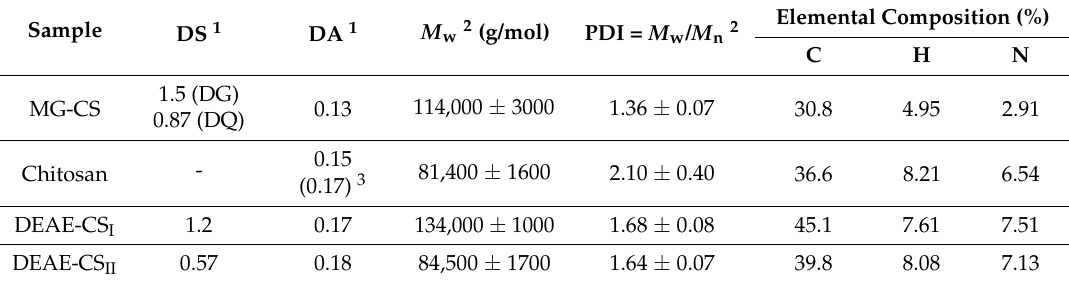
Table 1. Characteristics of the chitosan